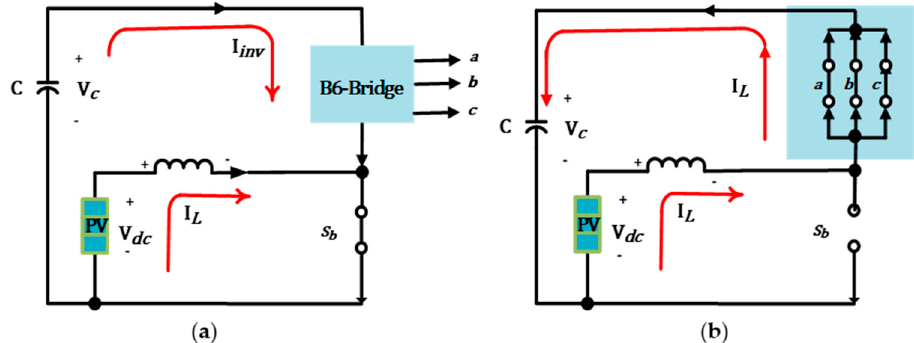
Figure 2. The simplified equivalent schematic circuit diagram of the single-input ´Cuk-derived Buck-Boost voltage source inverter (CBBVSI); ( a ) Mode 1: charging mode; ( b ) Mode2: discharging mode.